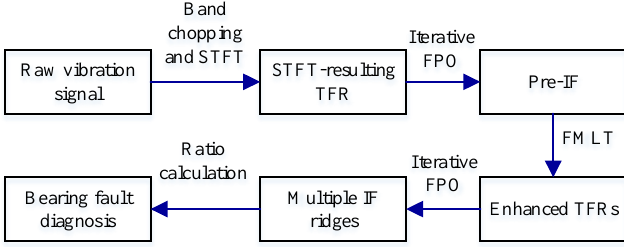
Figure 5. The flowchart of multiple IF ridge extraction.